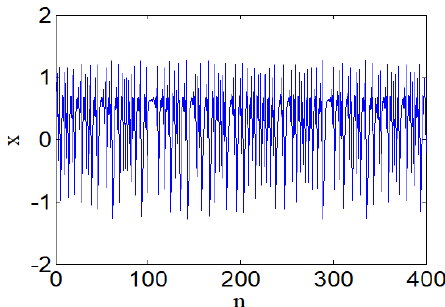
Figure 3. The time series diagram of the fractional-order Henon map with α = 0.99 and b = .